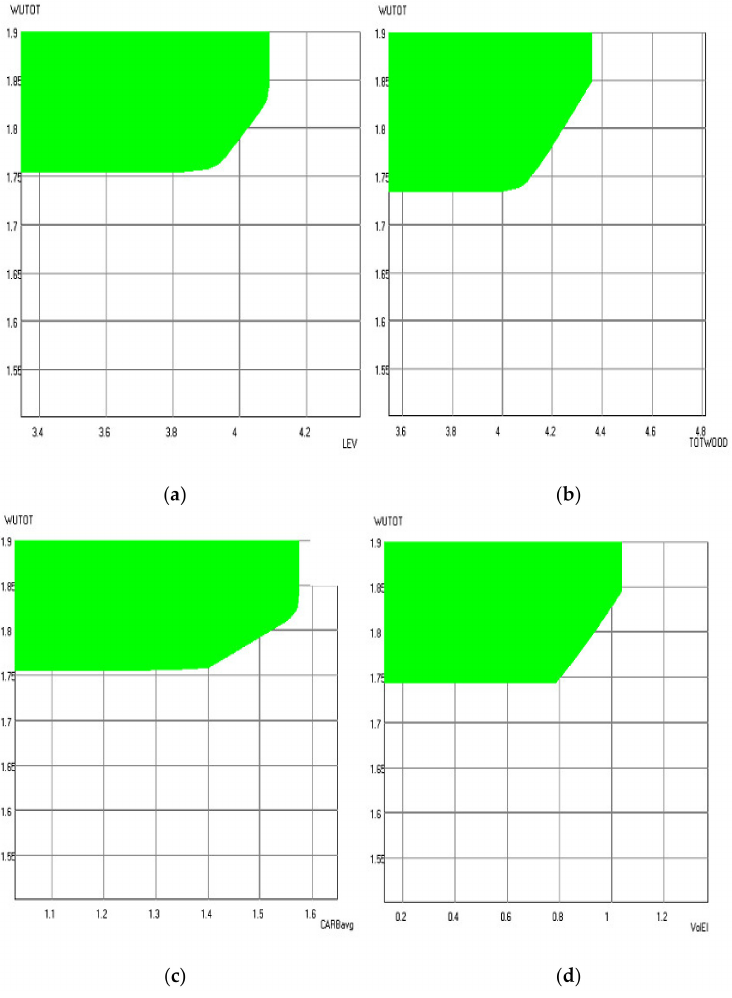
Figure 8. Illustration of two-dimensional decision maps showing tradeoffs between total water use (WUTOT, 10 8 m 3 ) and ( a ) LEV (10 9 ETB), ( b ) total harvested wood volume (TOTWOOD, 10 5 m 3 ), ( c ) carbon stock (CARBavg, 10 7 kg), and ( d ) volume of ending inventory (VolEI, 10 5 m 3